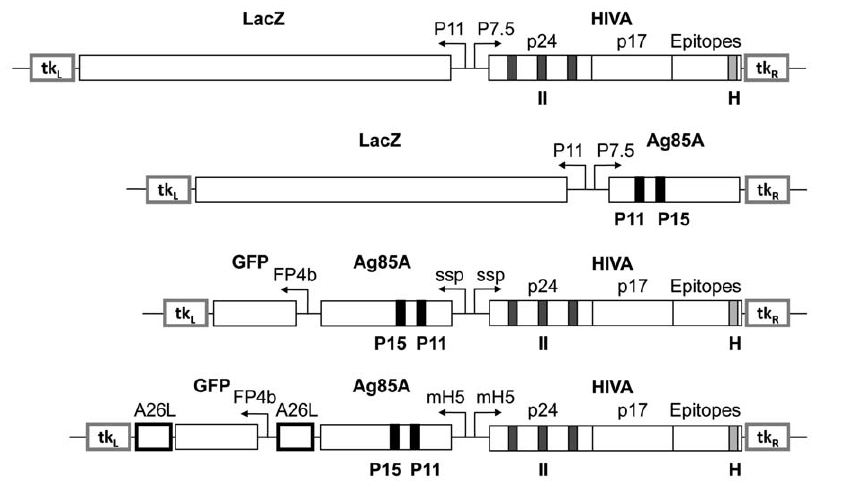
Figure 1. Schematic representation of inserted DNA fragments. Expression cassettes containing genes coding for immunogens HIVA and Ag85 using either b -galactosidase or GFP markers were inserted into the tk locus of the MVA genome by homologous recombination directed by the left and right tk flanking regions (tk L and tk R ). Transcription of the two immunogens was controlled by either P7.5, modified H5 (mH5) or short synthetic (ssp) promoters. In the mH5 version, the GFP gene is flanked by two homologous repeats (A26L), which facilitate removal of the selection marker. Proteins/epitopes are shown in bold, while promoters are indicated using a regular font style.